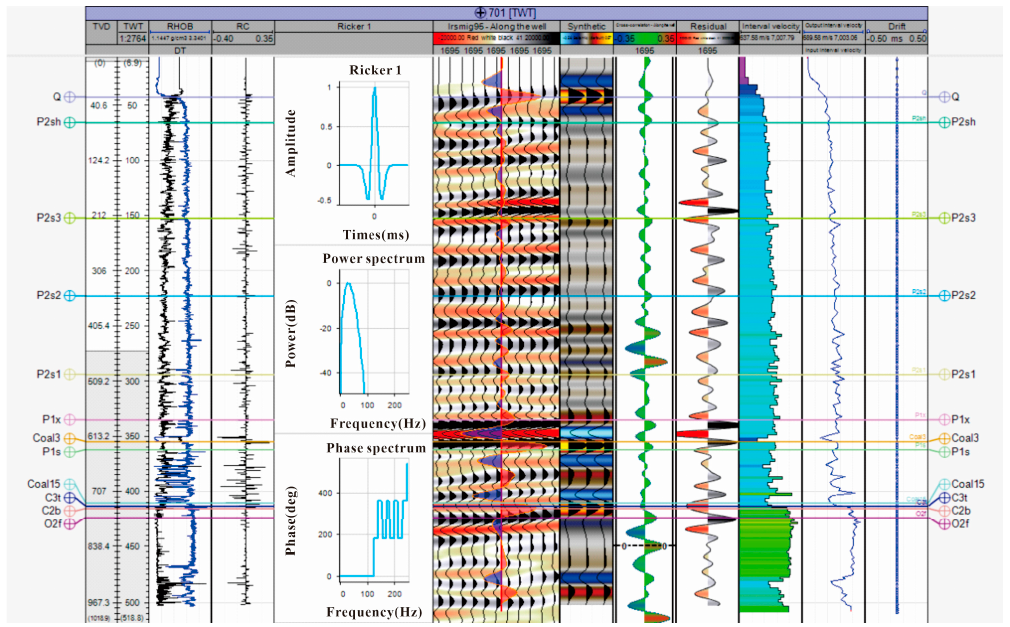
Figure 5. Synthetic seismogram of borehole 701.